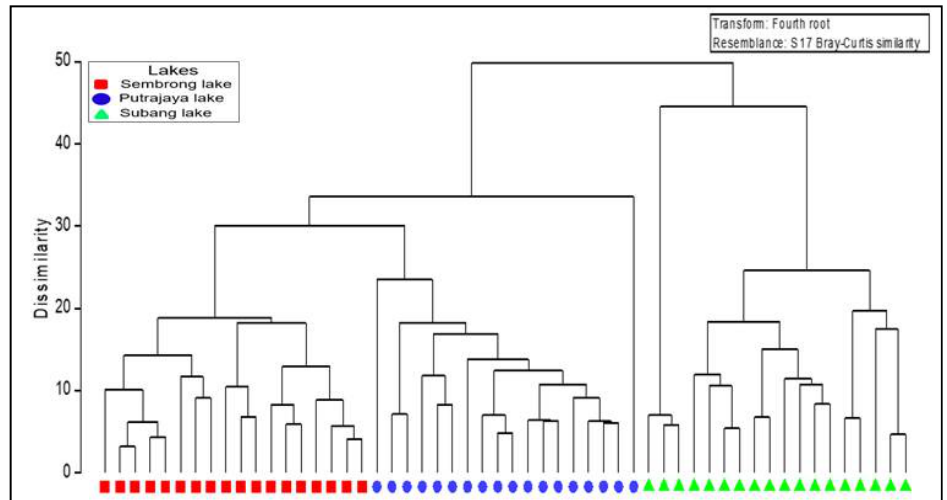
Figure 4. Dendrogram of microcrustacean densities (ind. L −1 ) illustrating that microcrustacean densities were clustered in three different groups corresponding to the three lakes. Table 4. Pairwise R-statistical values and significant levels ( p ) for two-way analysis of similarities (ANOSIM) test on microcrustacean densities in different lakes with Global R = 0.85. Group (Lakes) R Significance Level %)